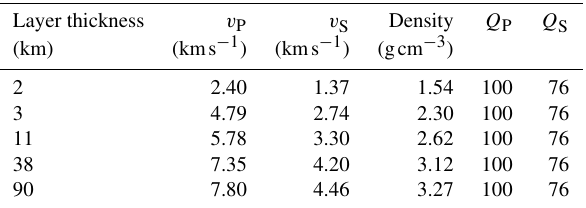
Table 2. Velocity model for forward modeling of crustal reverbera-